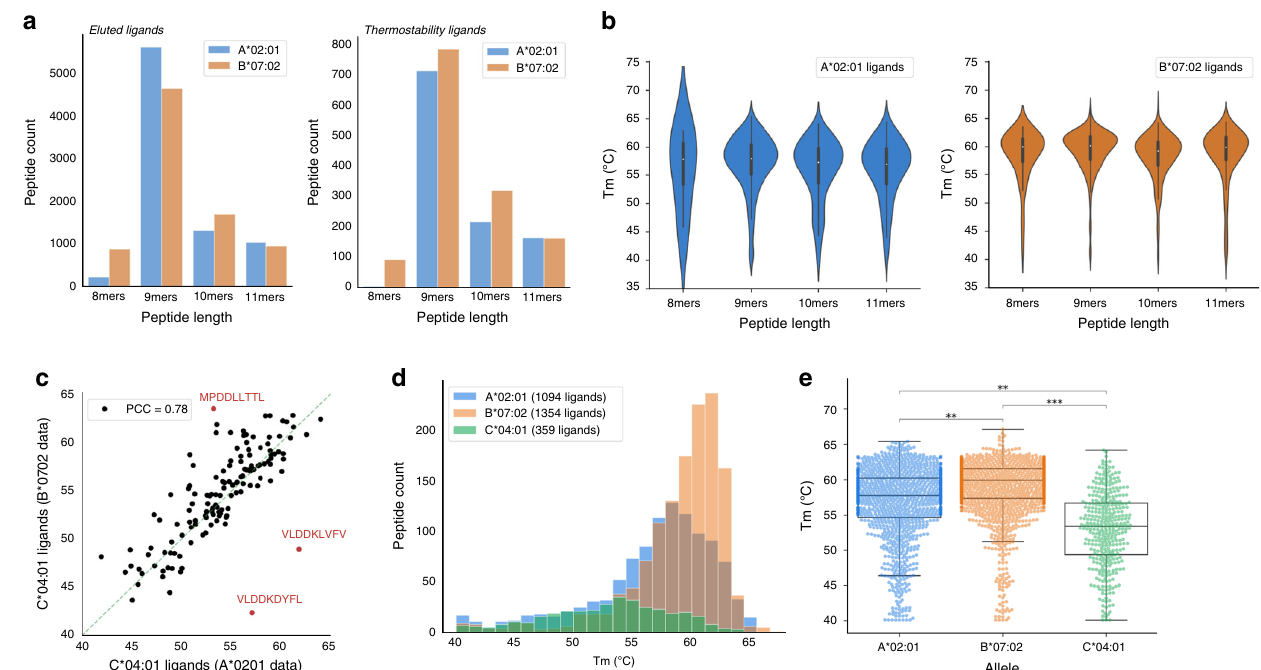
Fig. 2 Signi fi cant inter-allelic differences are observed in T m distributions. The length distributions of peptides bound to either HLA-A*02:01 or HLA- B*07:02 identi fi ed in the thermostability assay and the immunoprecipitation of pHLA complexes using established work fl ows 9 were as expected from previous immunopeptidomics studies, with ligands being predominantly 9-mers. b T m values for 1094 HLA-A*02:01-restricted peptides do not differ signi fi cantly based on their length ( p = 0.016, Kruskal-Wallis test; individual length comparisons with Mann-Whitney U test with Bonferroni adjustment for multiple comparisons, p > 0.05). T m values for 1354 HLA-B*07:02-restricted peptides do not differ signi fi cantly for all but one of the length comparisons, with a difference observed between the T m distributions of 9mers and 10mers; p = 5.20*10 -5 , Kruskal-Wallis test; individual length comparisons with Mann-Whitney U test with Bonferroni adjustment for multiple comparisons, p > 0.05 for all but the 9mer and 10mer distributions with p = 1.20*10 -6 ). Violin plot representation of data shows the median as center white dot and 25 th percentile and 75 th percentile as bounds of the center black box. c There is a good correlation between the T m values for HLA-C*04:01-restricted peptides identi fi ed in either the C1R-A*02:01 or C1R-B*07:02 assay (PCC = 0.78) demonstrating high assay robustness. This correlation is further improved (PCC = 0.87) when removing outlier peptides (indicated in red) that have high binding af fi nity to other alleles expressed by the C1R cell line. d T m distributions for HLA-A*02:01 (blue), HLA-B*07:02 (orange) and HLA-C*04:01 (green), expressed by the C1R cell lines studied show that there is a substantial difference in their variance (transparency is given to the bars to visualize their overlap and allele-speci fi c distributions). e A signi fi cant difference in the T m distribution for peptides restricted by HLA-A*02:01 (1094 peptides), HLA- B*07:02 (1354 peptides) and HLA-C*04:01 (359 peptides) is observed; p = 1.48*10 -93 , Kruskal-Wallis test; ** p < 10 -25 , *** p < 10 -50 , Mann – Whitney U test with Bonferroni adjustment for multiple comparisons. Box plot representation of data shows the median as center, 25 th percentile and 75 th percentile as bounds of boxes, maximum as 75 th percentile + 1.5 times the interquartile range and minimum as 25 th percentile - 1.5 times the interquartile range. PCC: Pearson Correlation Coef fi